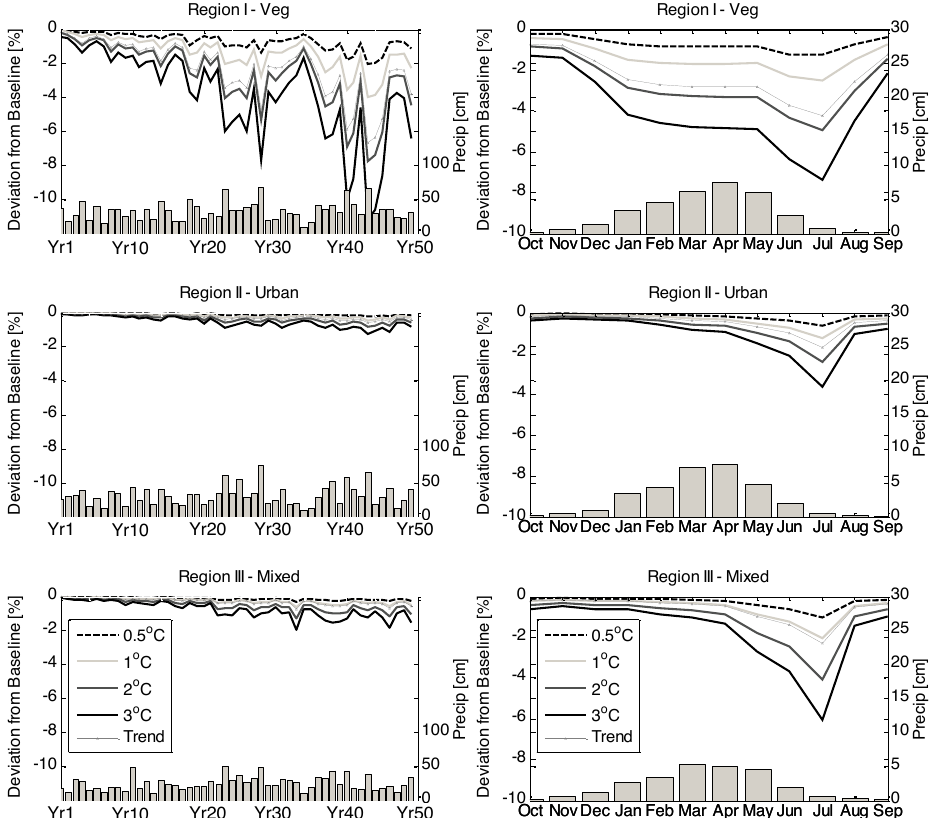
Fig. 5. Percent change in total annual flow (left) and mean monthly flow (right) from baseline simulations for the 50yr increasing temperature scenarios only. The bottom bar graphs are the total annual precipitation (left) and mean monthly precipitation (right) used for each region. These temperature increase scenarios had no change in baseline